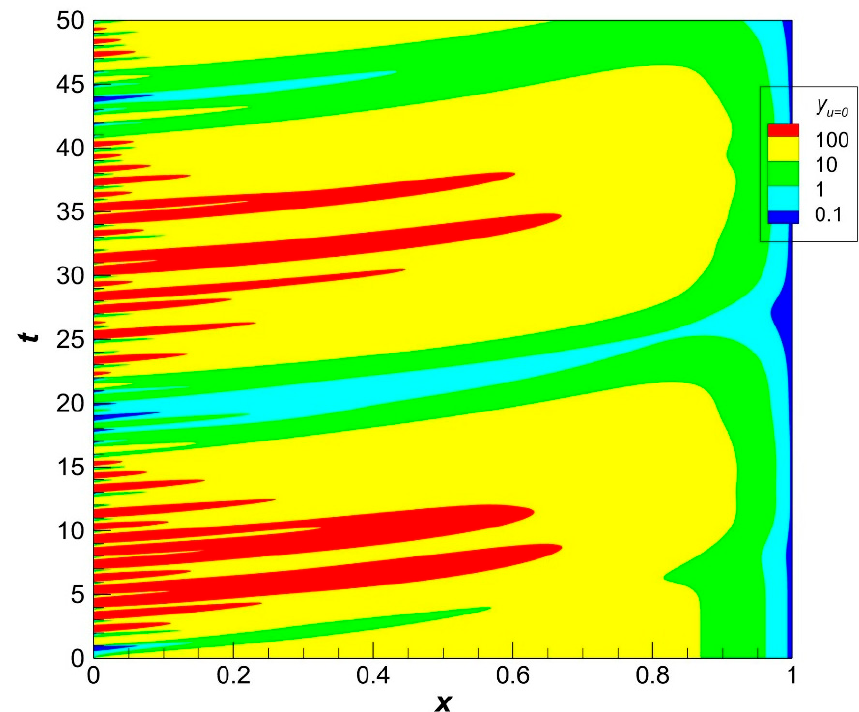
Figure 3. The population density y ( t , x ) for the basic scenario without harvesting.